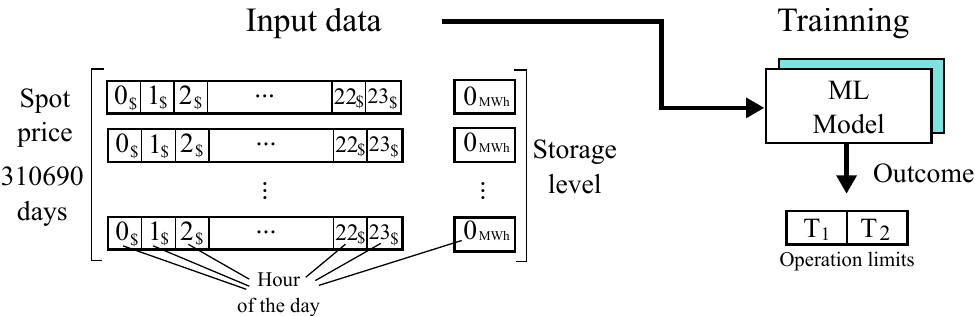
Figure 7. Machine learning model applied in the proposed study case. The input variables are the 24 h electricity price from the day-ahead market and the initial level of the storage unit at hour 0. The outputs are the two operating thresholds for that specific day.